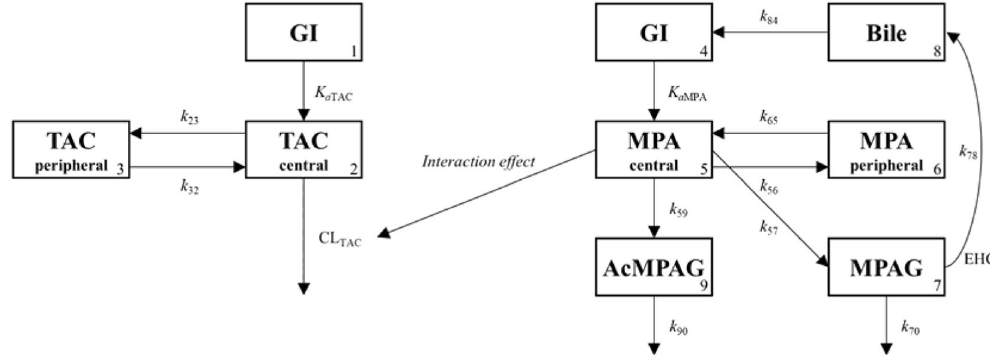
Figure 1. Schematic presentation of an integrated population pharmacokinetic model. Compartments: gastrointestinal tract (GI, 1, 4), central compartment for tacrolimus (2); peripheral compartment for tacrolimus (3), central compartment for mycophenolic acid (5), peripheral compartment for mycophenolic acid (6), compartment for mycophenolic acid 7-O-glucuronide (7), compartment for gallbladder (8), compartment for mycophenolic acid acyl glucuronide (9). TAC, tacrolimus; K a , absorption rate constant; k 23 , k 32 , k 56 , and k 65 , intercompartment rate constants; CL , clearance; MPA, mycophenolic acid; MPAG, MPA 7-O-glucuronide; AcMPAG, MPA acyl glucuronide; k 57 and k 59 , metabolized rate constants for mycophenolic acid; EHC, enterohepatic circulation; k 78 , biliary recirculation of MPAG into GI; k 70 and k 90 , eliminated rate constants; k 84 , gallbladder emptying rate constant; Meal times were used to trigger timing of gallbladder